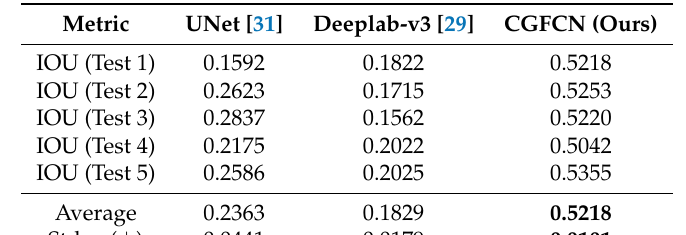
Table 2. A comparison of different methods: UNet [31], Deeplab-v3 [29] and CycleGAN based Fully Convolutional Networks (CGFCN) (Ours). All methods are trained based on the synthetic data and then tested on real data. For each of these methods, we individually train each model for five times and then record the accuracy of each model on our test set (marked as “Test-1” ∼ “Test-5”). The CGFCN obtains the best results in both mean accuracy and stability.